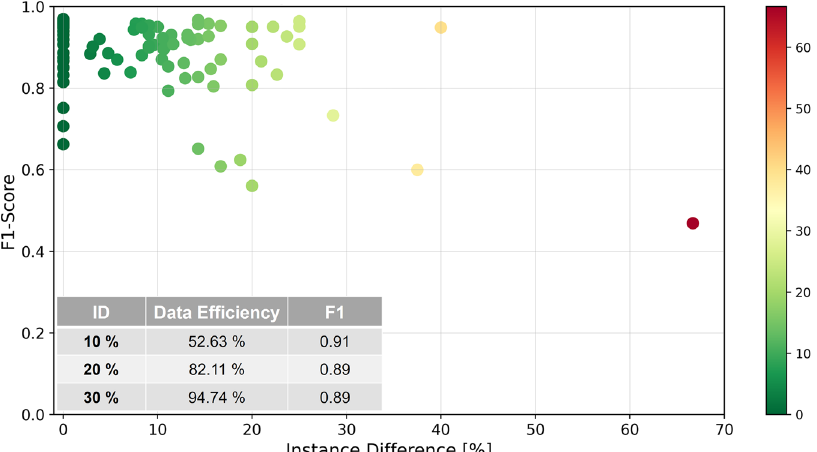
Fig. 7 F1-score in dependency of the instance difference (ID) given as a % for the Au/Ge system. A table summarising selected ID values with respective data ef fi ciency and calculated F1-scores is